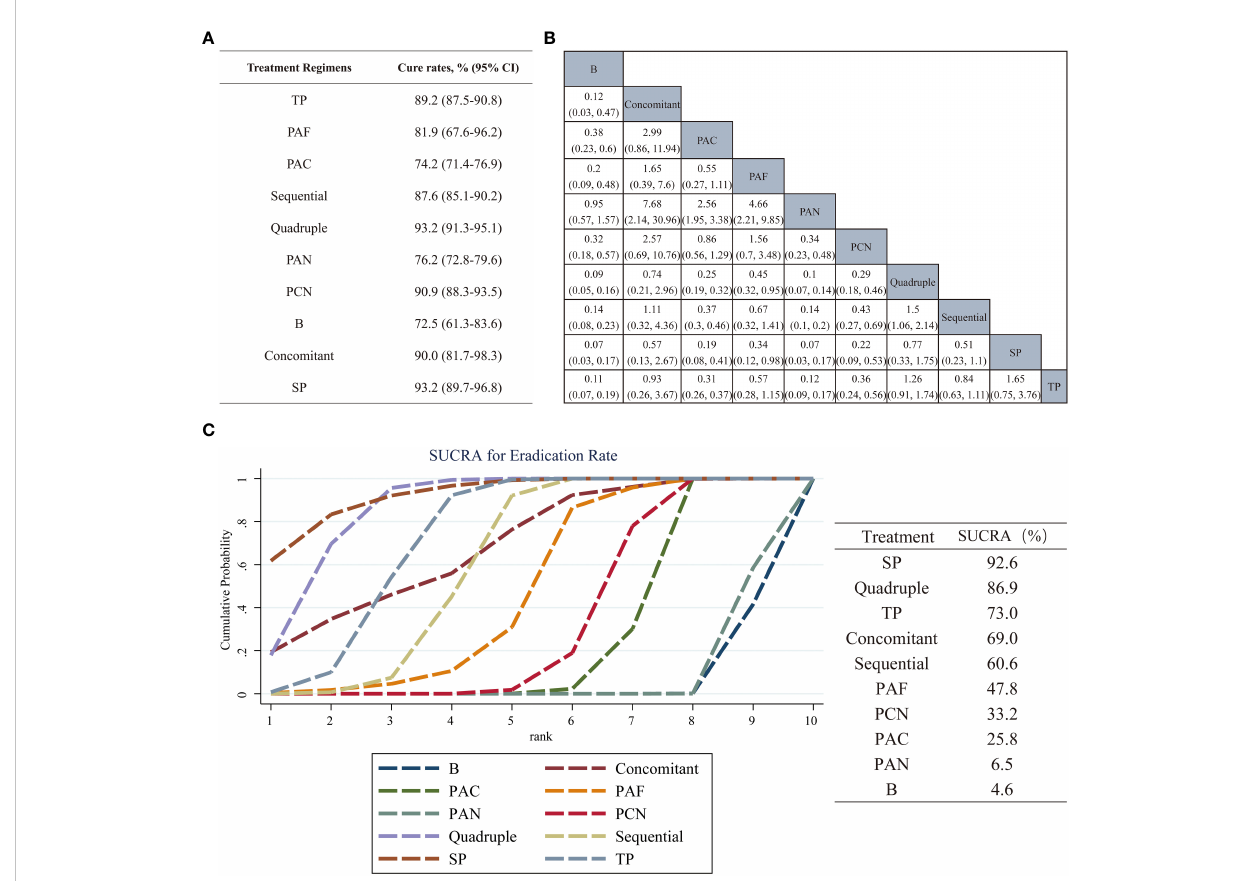
FIGURE 5 (A) Statistical results of the overall cure rates of 10 eradication regimens for Helicobacter pylori infection in children. (B) The comparison league table of 10 eradication programs. The values in the table are the effect sizes and 95% con fi dence intervals of the treatment measures in the column and the row. (C) The SUCRA was used to rank the ef fi cacy of the 10 eradication regimens included. The larger the area under the curve, the better the therapeutic effect. Regimen labels: B, bismuth-containing triple therapy; Concomitant, concomitant therapy; PAC, PPI, amoxicillin and clindamycin; PAF, PPI, amoxicillin and furanes; PAN, PPI, amoxicillin and nitroimidazoles; PCN, PPI, clindamycin and nitroimidazoles; Quadruple, quadruple therapy; Sequential, sequential therapy; SP, sequential therapy with probiotics; TP, triple therapy with